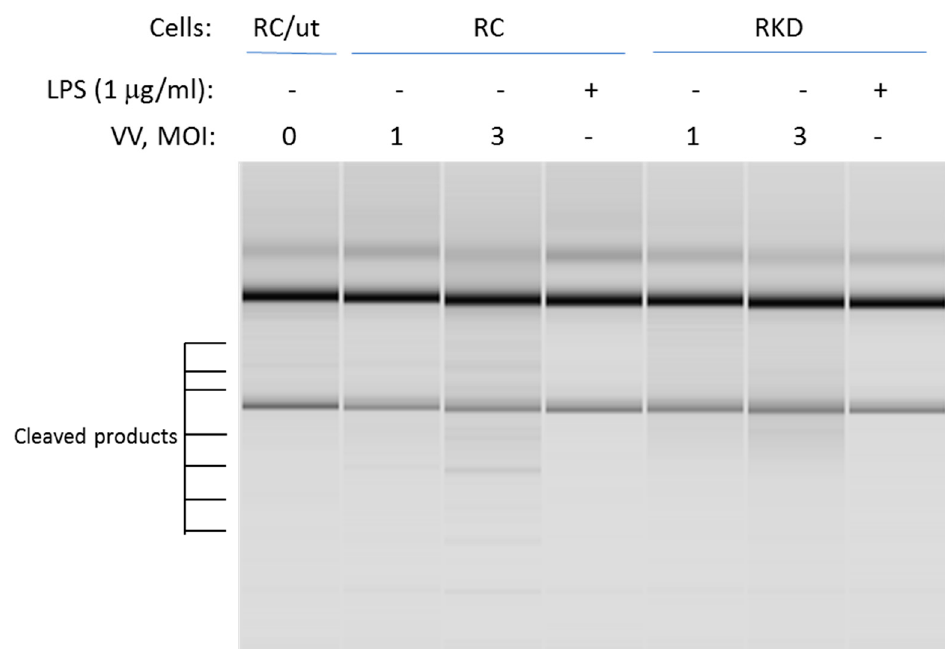
Figure 5. Analysis of RNase L nuclease activity against rRNAs. RNase L wild type and knockdown Raw 264.7 cells were infected by vaccinia virus (VV) with a MOI at 1 and 3; or treated with 1 µg/mL of LPS for 16 h. Total RNA was isolated from the cells using the Trizol reagent according to manufacturer’s instruction. The cleavage of rRNAs in the cells was measured in RNA chips as described in Methods. MOI: multiplicity of infection; RC/ut: Raw Control/Untreated. The experiment was performed twice.